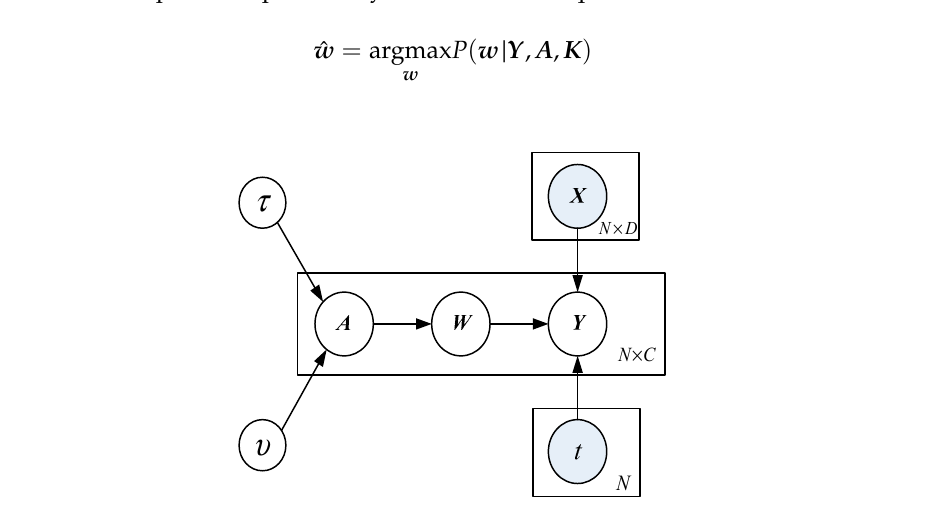
Figure 2. Plates diagram of the multiclass relevance vector machine (mRVM) model.